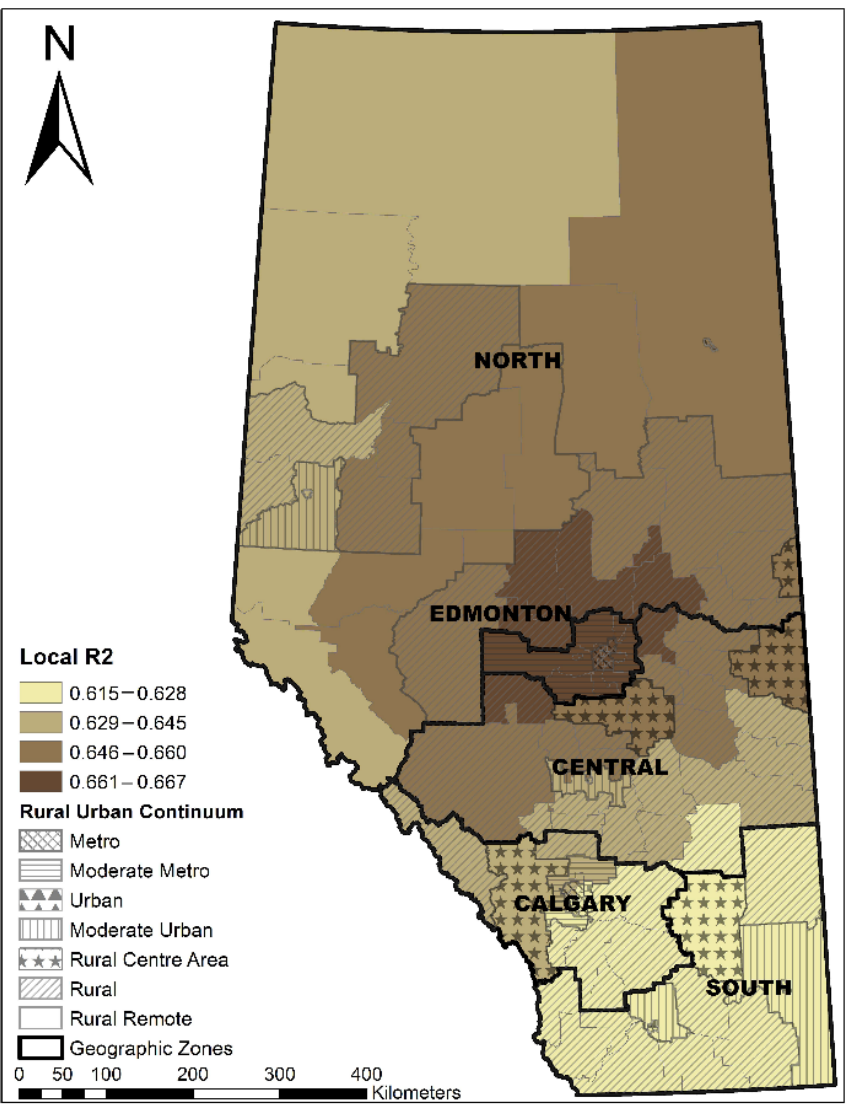
Figure 3. Distribution of local R 2 of the GWR model.